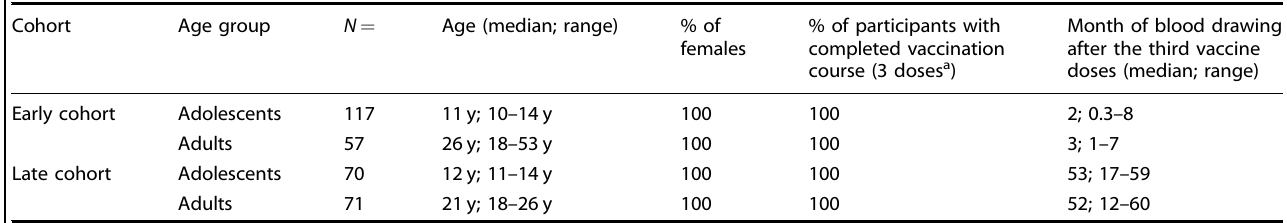
Table 1. Cohort description.